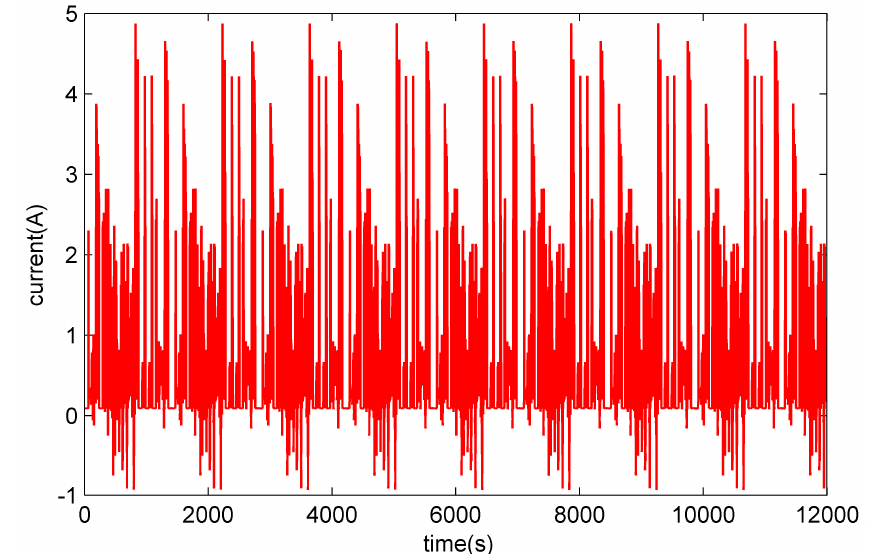
Figure 4. The current profile under the City test.